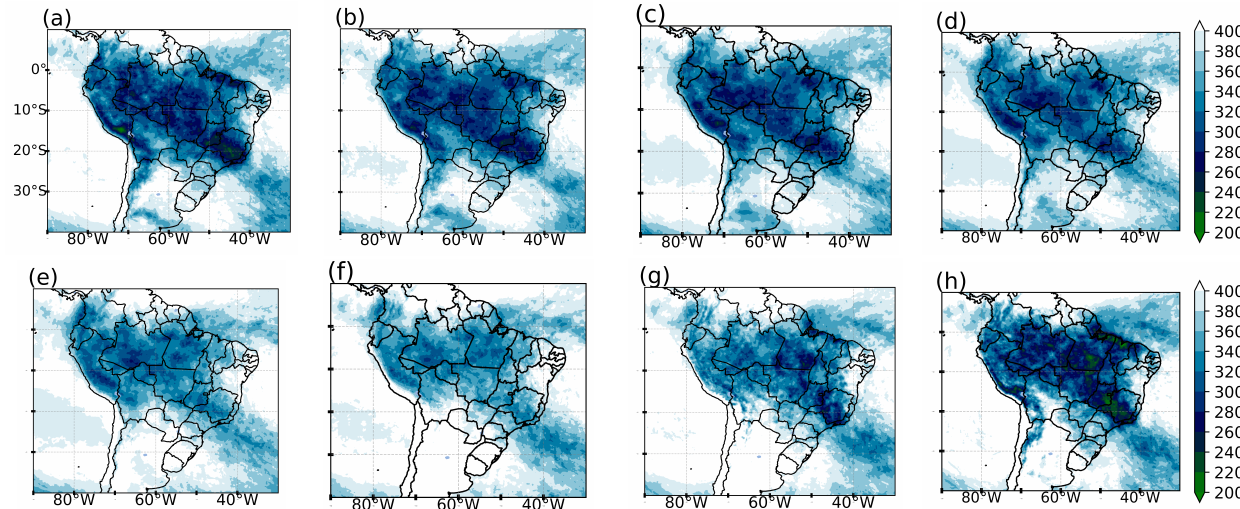
Figure 8. Composites of the diurnal spatial cycle of the OLR to ( a ) 00 UTC, ( b ) 03 UTC, ( c ) 06 UTC, ( d ) 09 UTC, ( e ) 12 UTC, ( f ) 15 UTC, ( g ) 18UTC, and ( h ) 21UTC of the SACZ events during the active phase of the MJO.